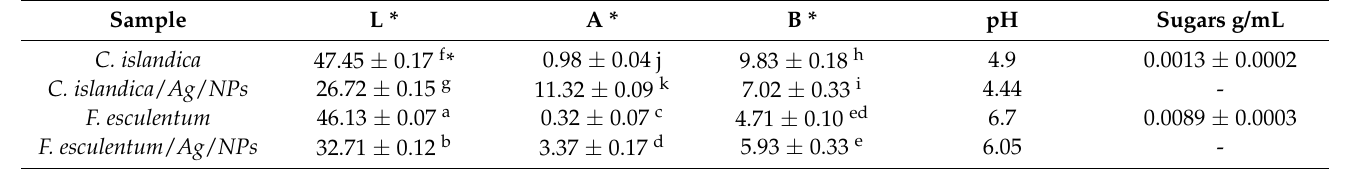
Table 1. Color coordinates, pH and sugar content in C. islandica and F. esculentum